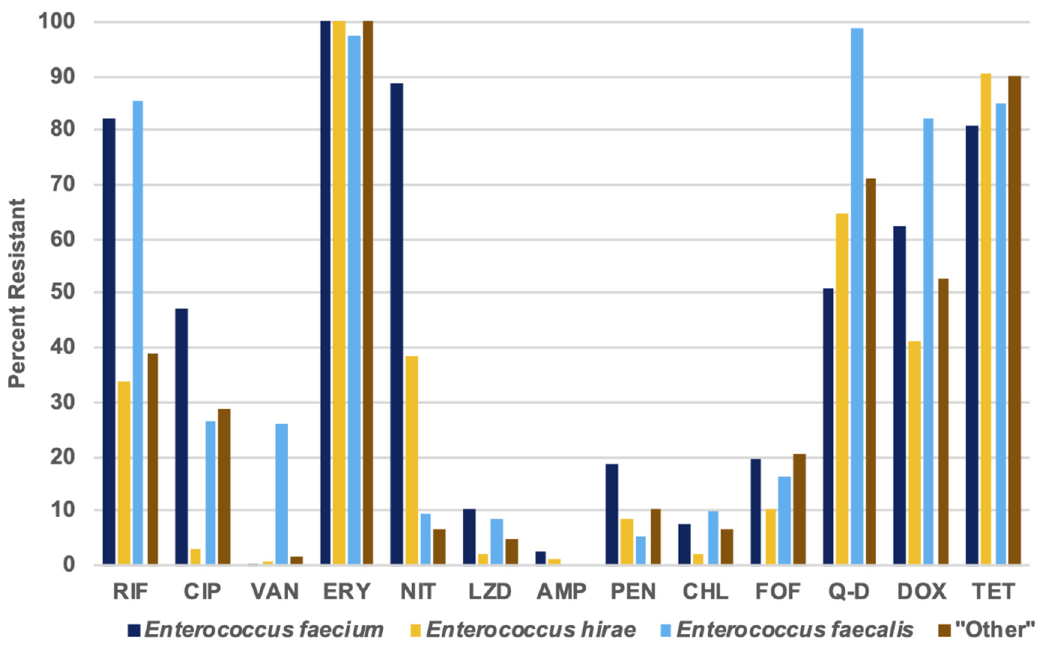
Figure 4. Numbers and percentages of resistance to each antimicrobial for all species of enterococci.